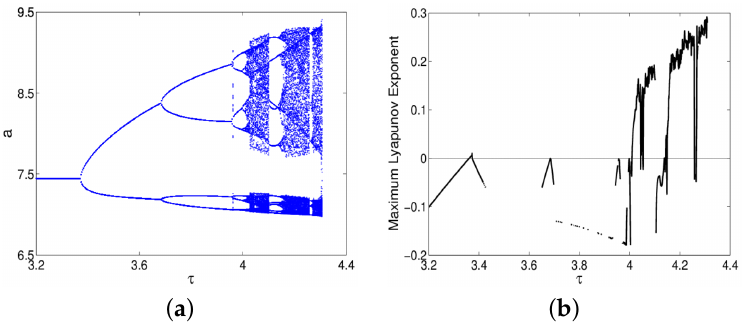
Figure 1. ( a ) Flip bifurcation diagram; ( b ) Maximum Lyapunov